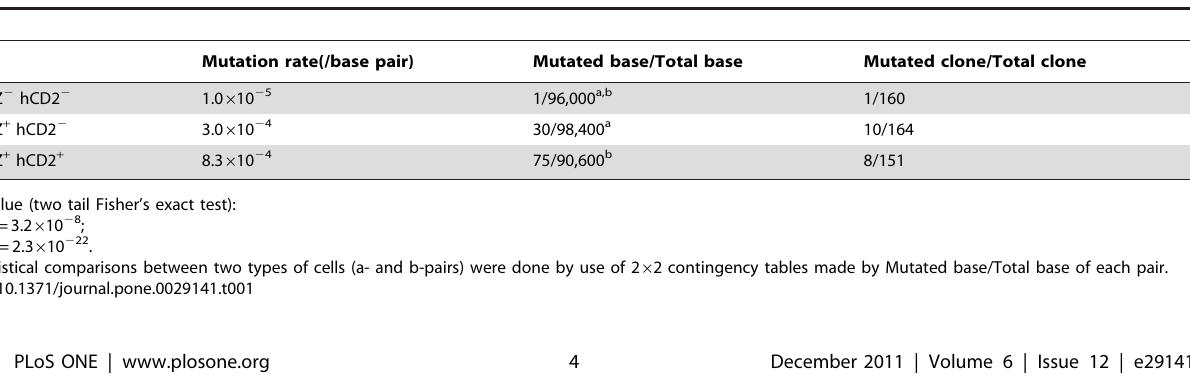
Table 1. Mutation frequency of Jh4 downstream intron of Igh of B220 + CD3 2 cells.